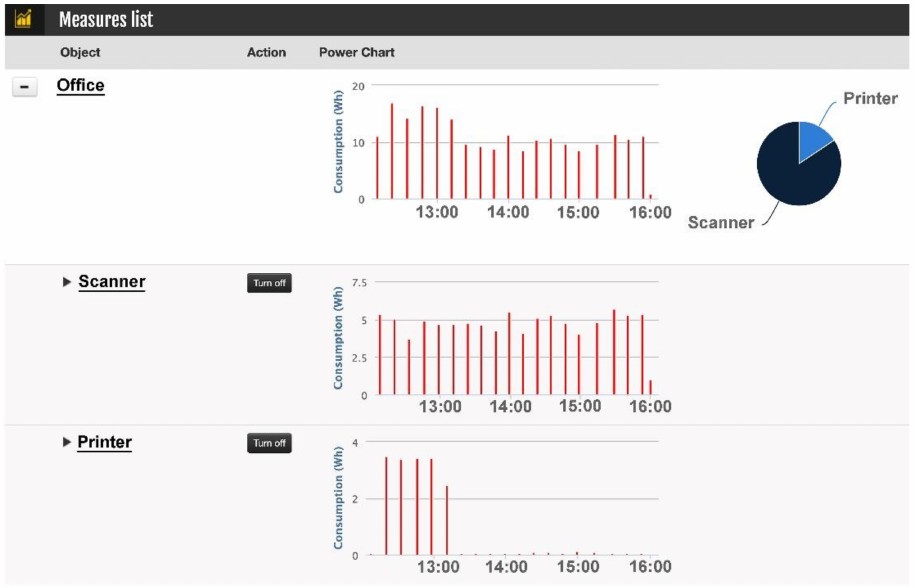
Figure 19. Consumption submetering (Wh) in an office